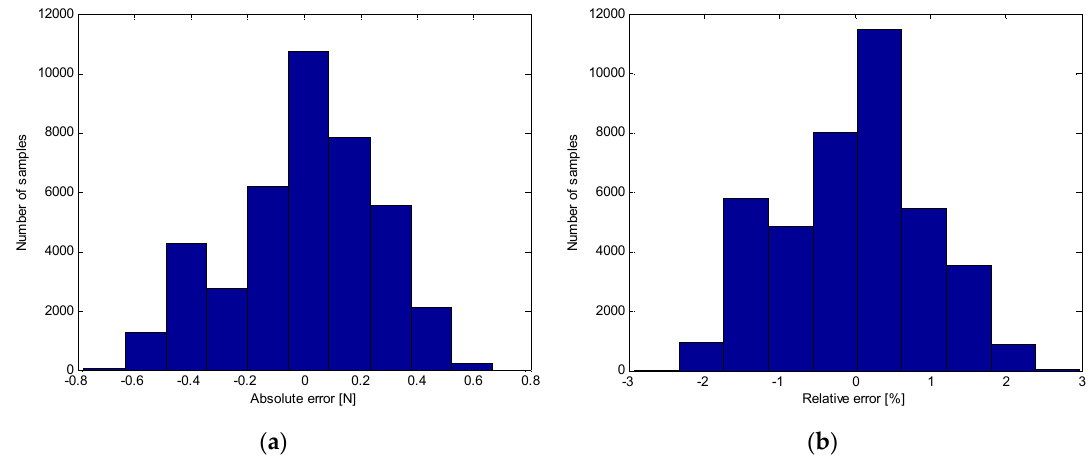
Figure 15. Distribution of force measurement errors: ( a ) Absolute error; ( b ) Relative error.